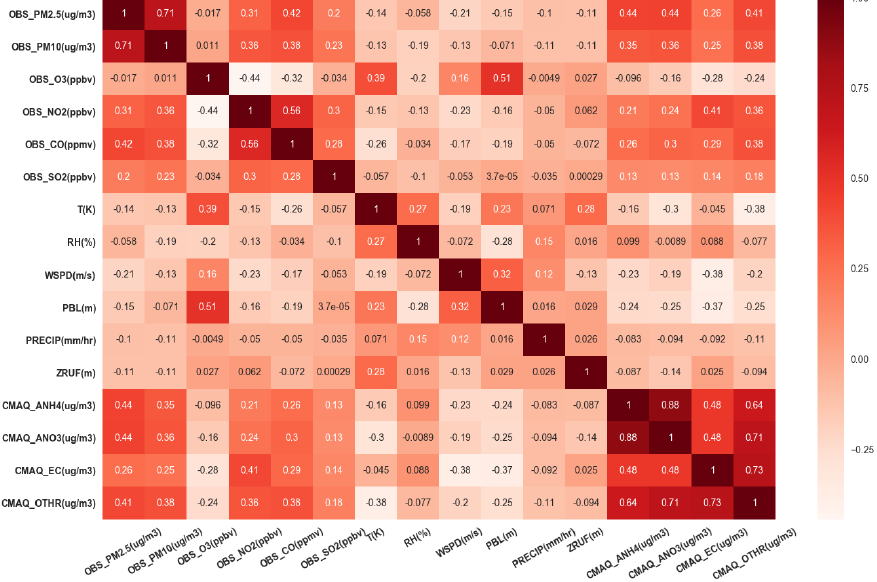
Figure 2. The correlation between PM 2.5 and other variables.